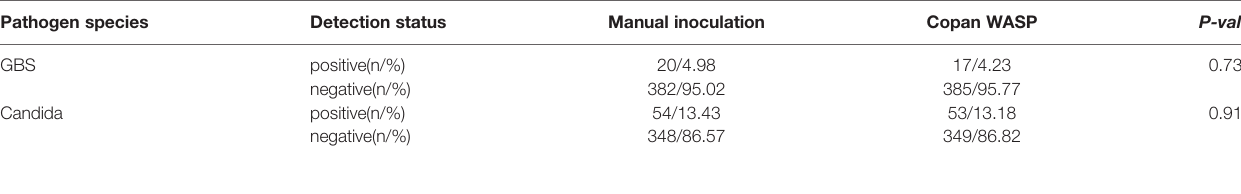
TABLE 2 | Comparison of the isolation and cultivation ef fi ciencies of common